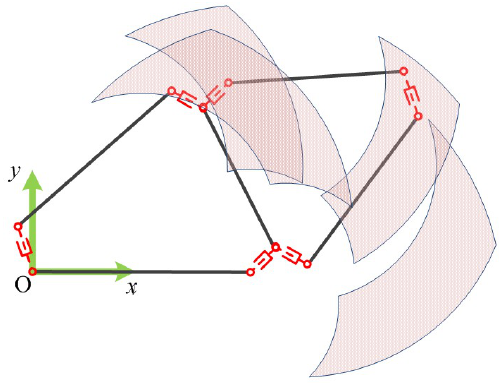
Figure 9. Area sections of F 1 with 16 key points.